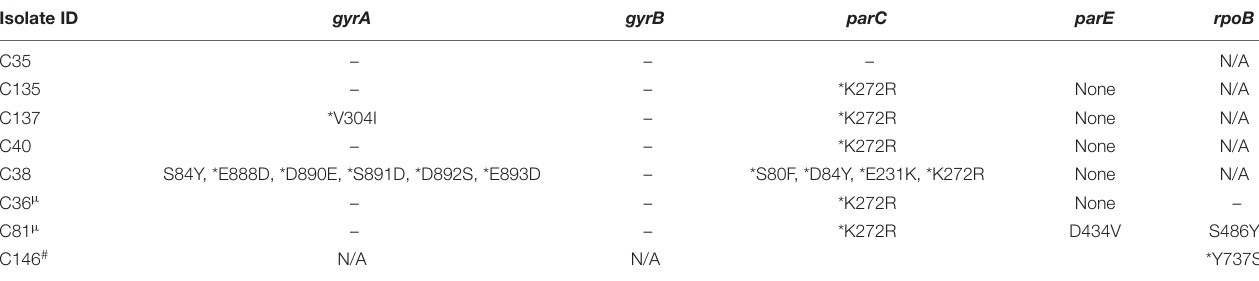
TABLE 4 | Mutations in gyrA , gyrB , parC , and parE in the Staphylococcus epidermidis isolates. Isolate ID